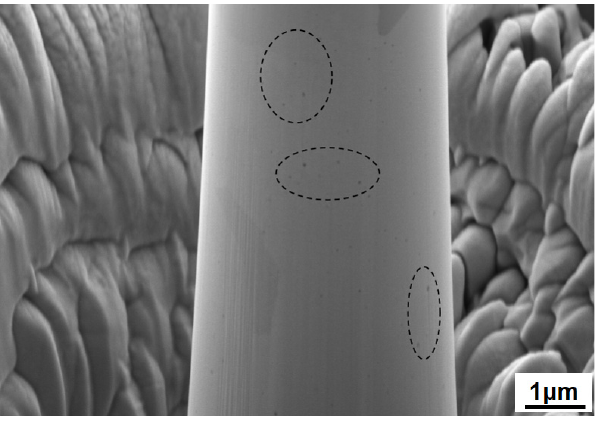
Figure 13. Nano-scale micro-pore clusters on the outer surface of SLM HEA FIB cone structure.